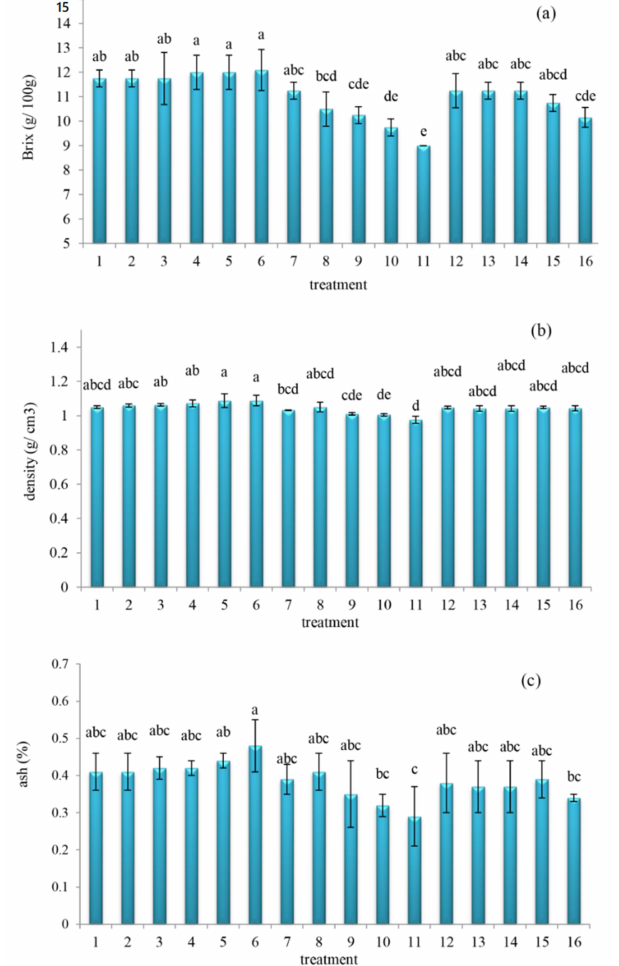
Figure 1. Changes in Brix ( a ), density ( b ), and ash ( c ) values of the orange juice subject to different oleaster extracts ((1) control, (2) aqueous extract 5%, (3) aqueous extract 10%, (4) aqueous extract 15%, (5) aqueous extract 20%, (6) aqueous extract 25%, (7) alcoholic extract 5%, (8) alcoholic extract 10%, (9) alcoholic extract 15%, (10) alcoholic extract 20%, (11) alcoholic extract 25%, (12) hydro-alcoholic extract 5%, (13) hydro-alcoholic extract 10%, (14) hydro-alcoholic extract 15%, (15) hydro-alcoholic extract 20%, (16) hydro-alcoholic extract 25%). Different letters (a–e) indicate significant changes occurred at p <